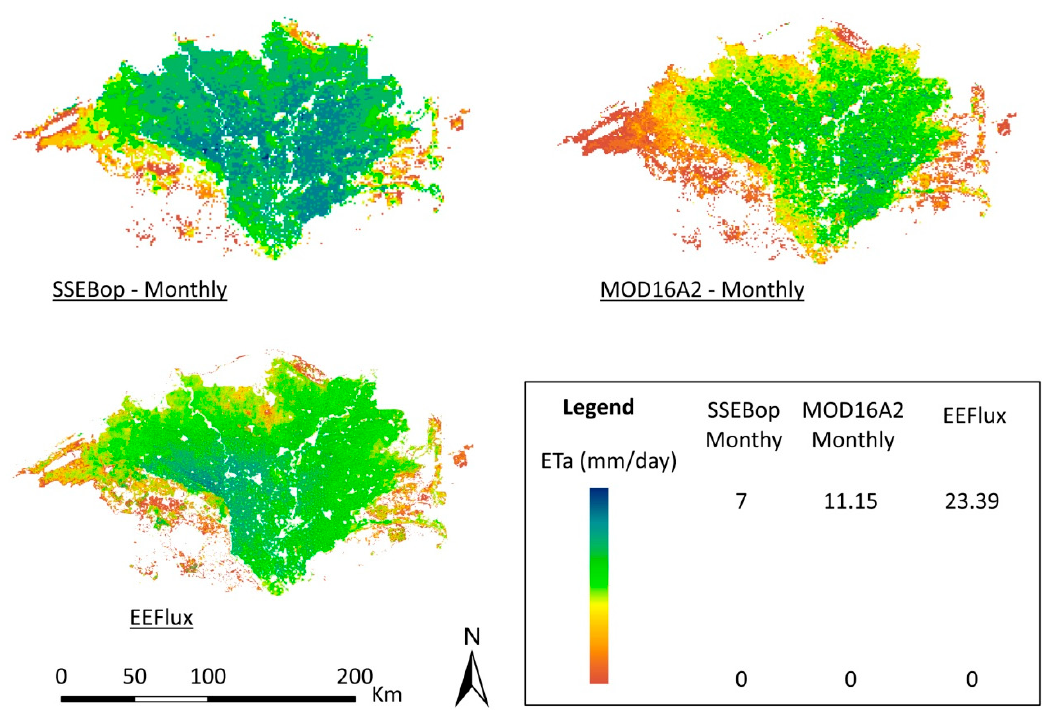
Figure 4. Mean daily Eta, estimated by the three selected products over the Nile Delta in August 2007.